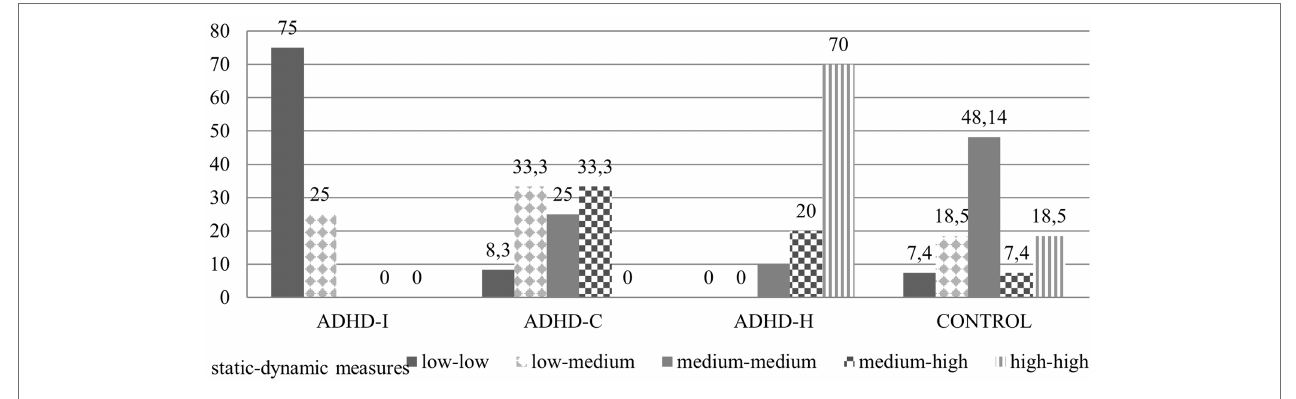
FIGURE 2 | Response rates.